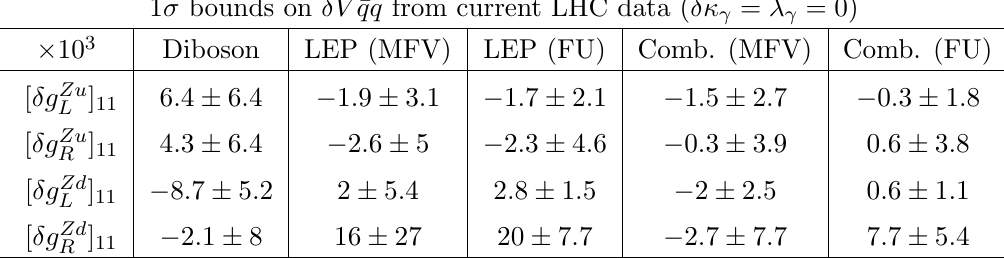
Table 3 . Constraints ( (cid:2) 10 3 ) on the (cid:14)V (cid:22) qq vertex corrections from a (cid:12)ve parameter global (cid:12)t combining LHC diboson data and LEP-1 measurements, setting (cid:14)(cid:20) (cid:13) = (cid:21) (cid:13) = 0. The (cid:12)rst column gives the bounds using the LHC diboson data from table 1 alone. The second and third columns report the LEP- 1 bounds derived in ref. [27] under the MFV and FU assumptions respectively. Finally, the last two columns show the combination of the current LHC and LEP-1 data for the two (cid:13)avour assumptions.